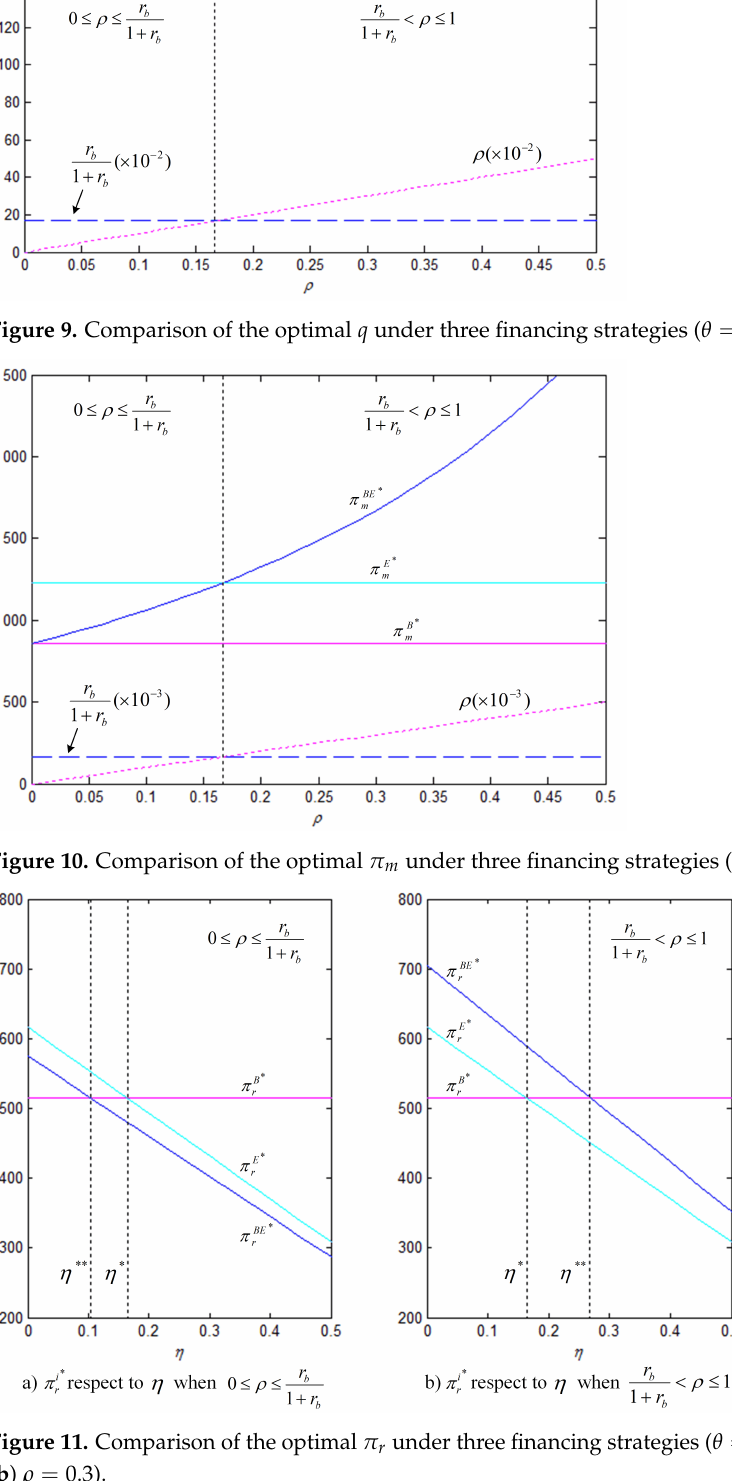
Figure 11. Comparison of the optimal π r under three financing strategies ( θ = 5, r b = 0.2, ( a ) ρ = 0.1, ( b ) ρ =